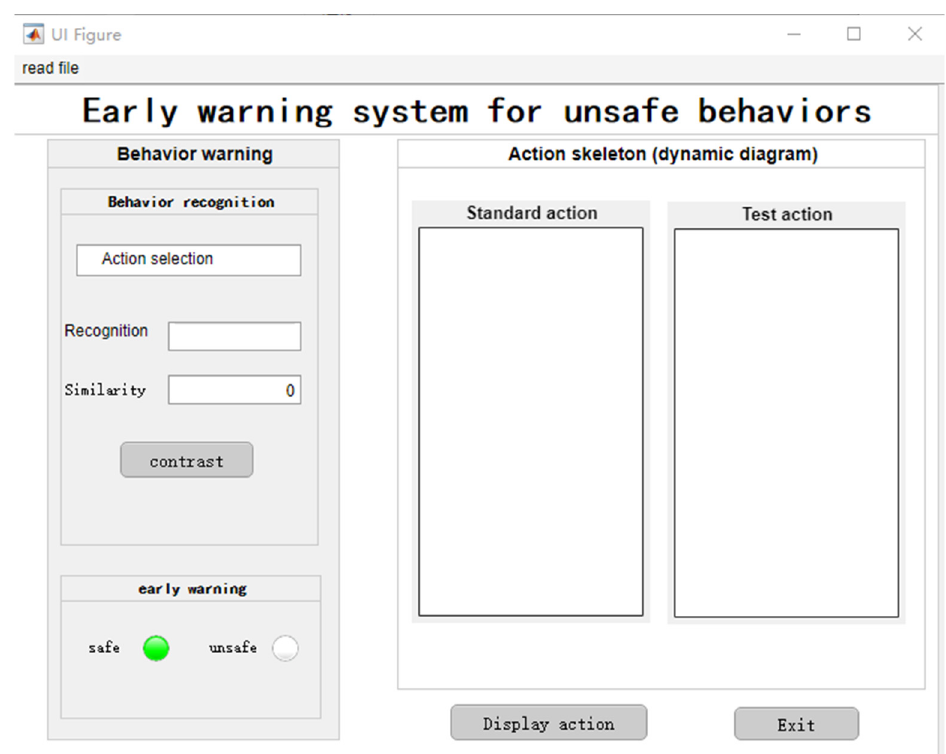
Figure 10. Identification and warning system of unsafe behaviors of metro passengers.